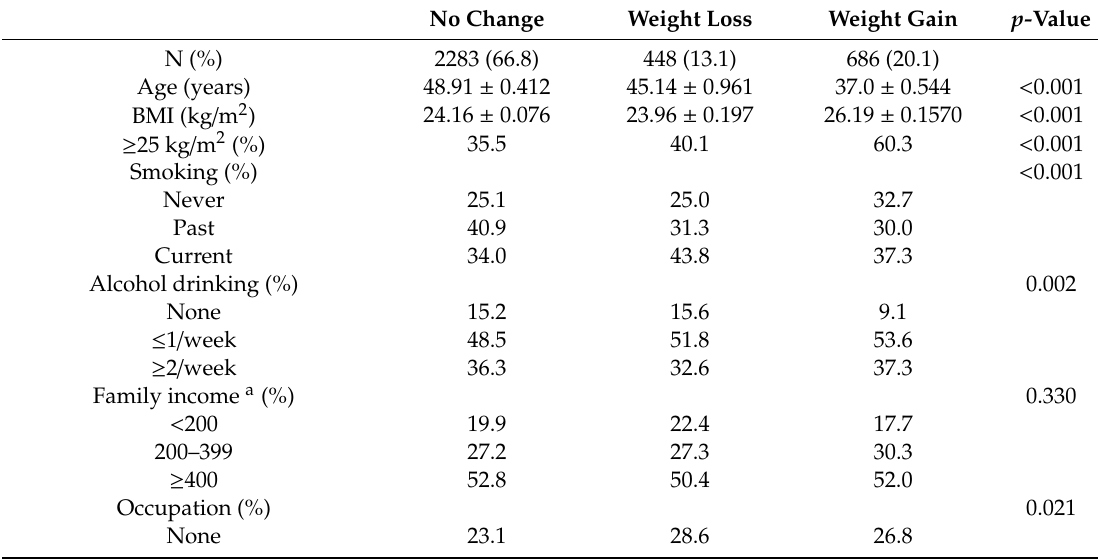
Table 1. Characteristics of the study population in